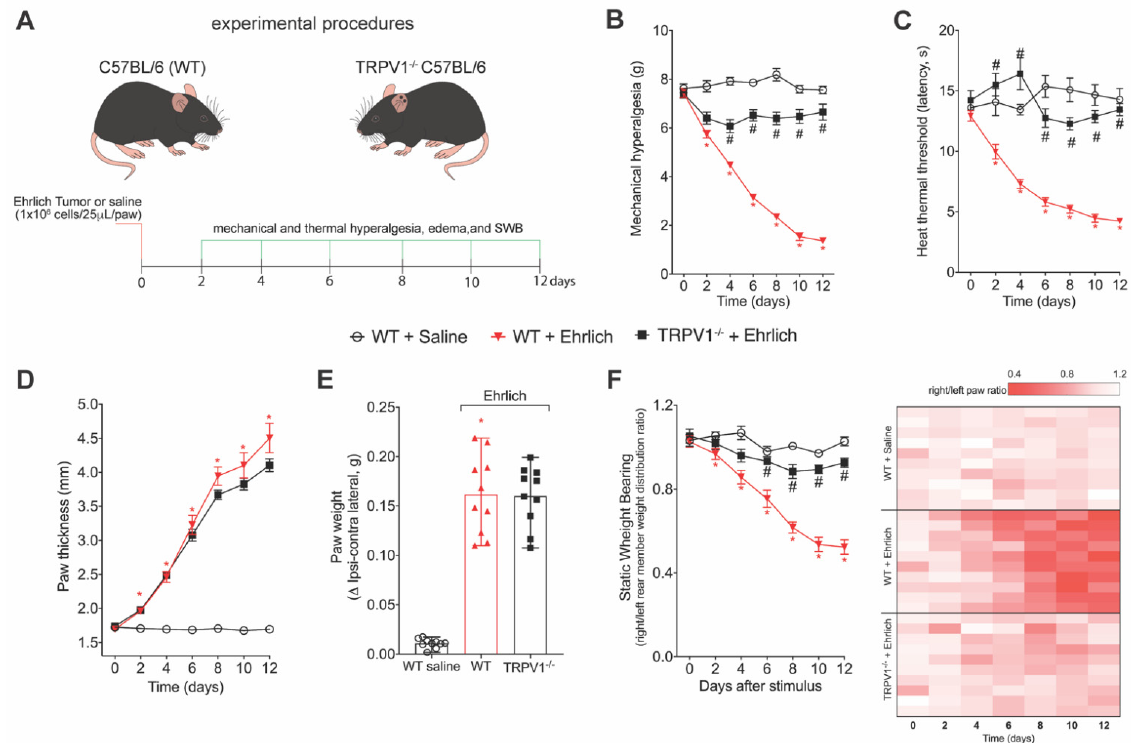
Figure 2. TRPV1 deficiency reduces Ehrlich tumor cells pain-like behavior without changing tumor growth parameters. ( A ) Experimental design. Male WT (Wild type) C57BL/6 and TRPV1 (transient receptor potential cation channel subfamily V member 1) deficient ( -/- ) (C57BL/6 background) mice were stimulated with intraplantar Ehrlich tumor cells at the load of 1 × 10 6 cells or saline on day